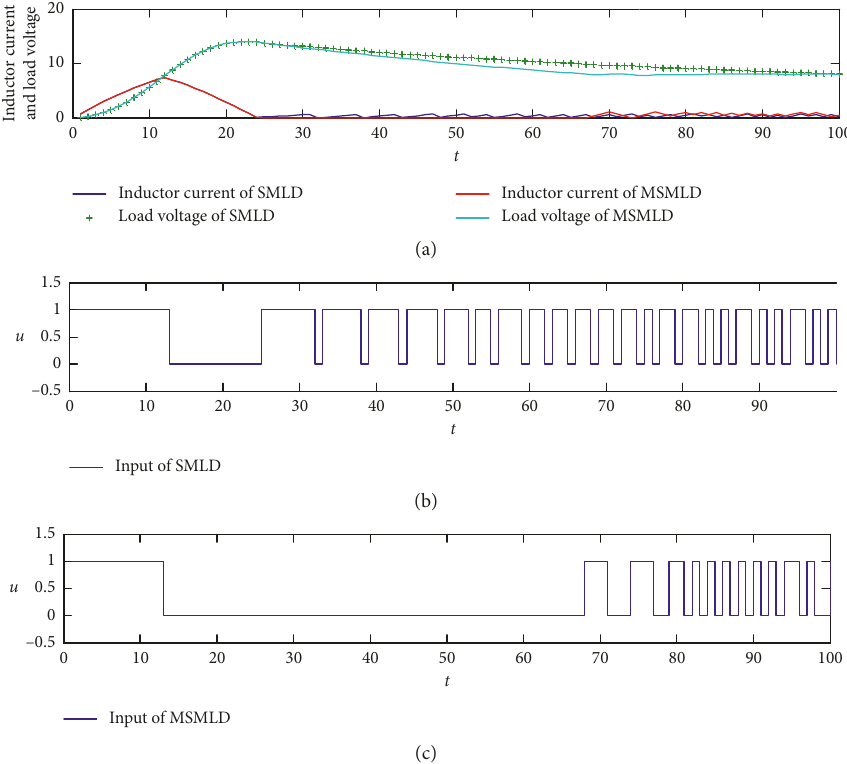
Figure 6: Comparison of SMLD and the proposed method. (a) System states of SMLD and MSMLD. Control input of (b) SMLD and (c) MSMLD.